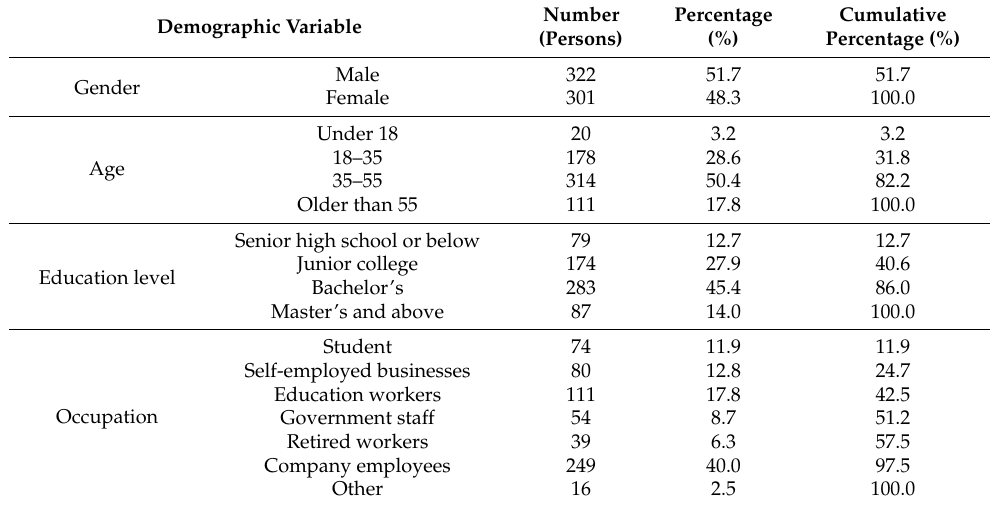
Table 10. Basic sample